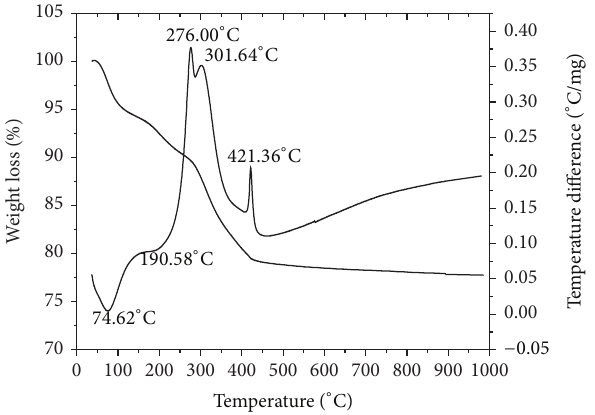
Figure 2: TGA and DTA profiles of Zr(OH) 4 .